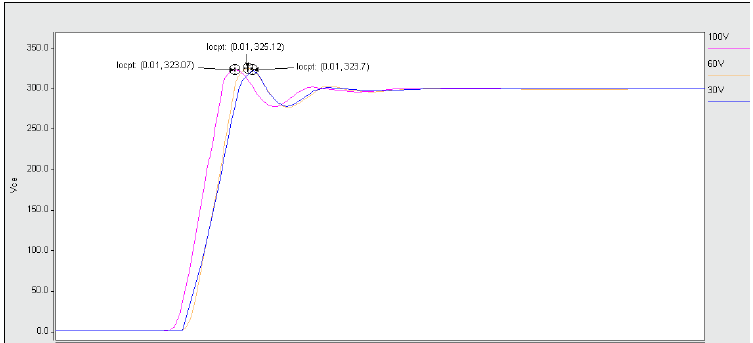
Figure 10. V ce comparison diagram under different U ZS 1 values.